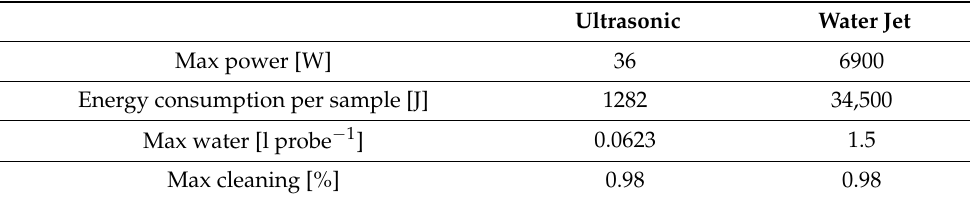
Table 9. Comparison between technologies.